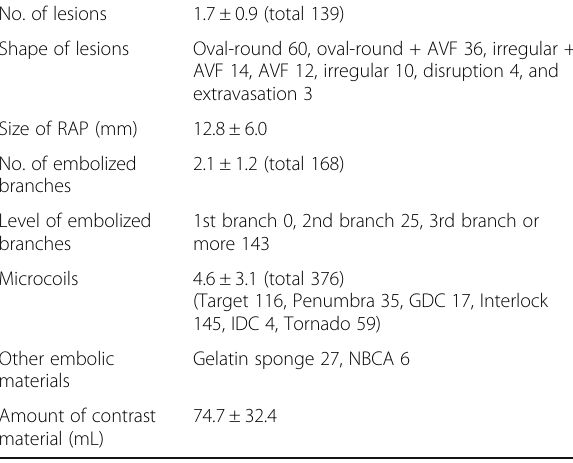
Table 2 Angiographic findings and embolization methods